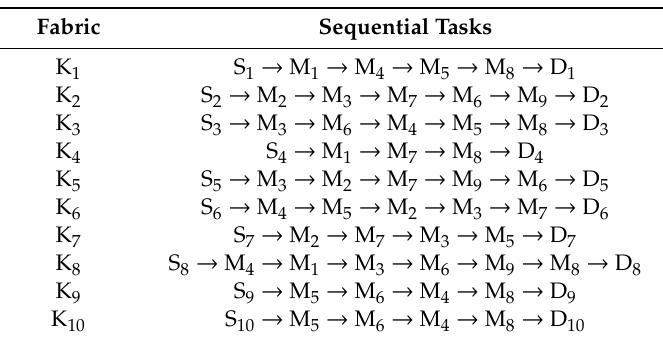
Table 2. Fabrics and their tasks.